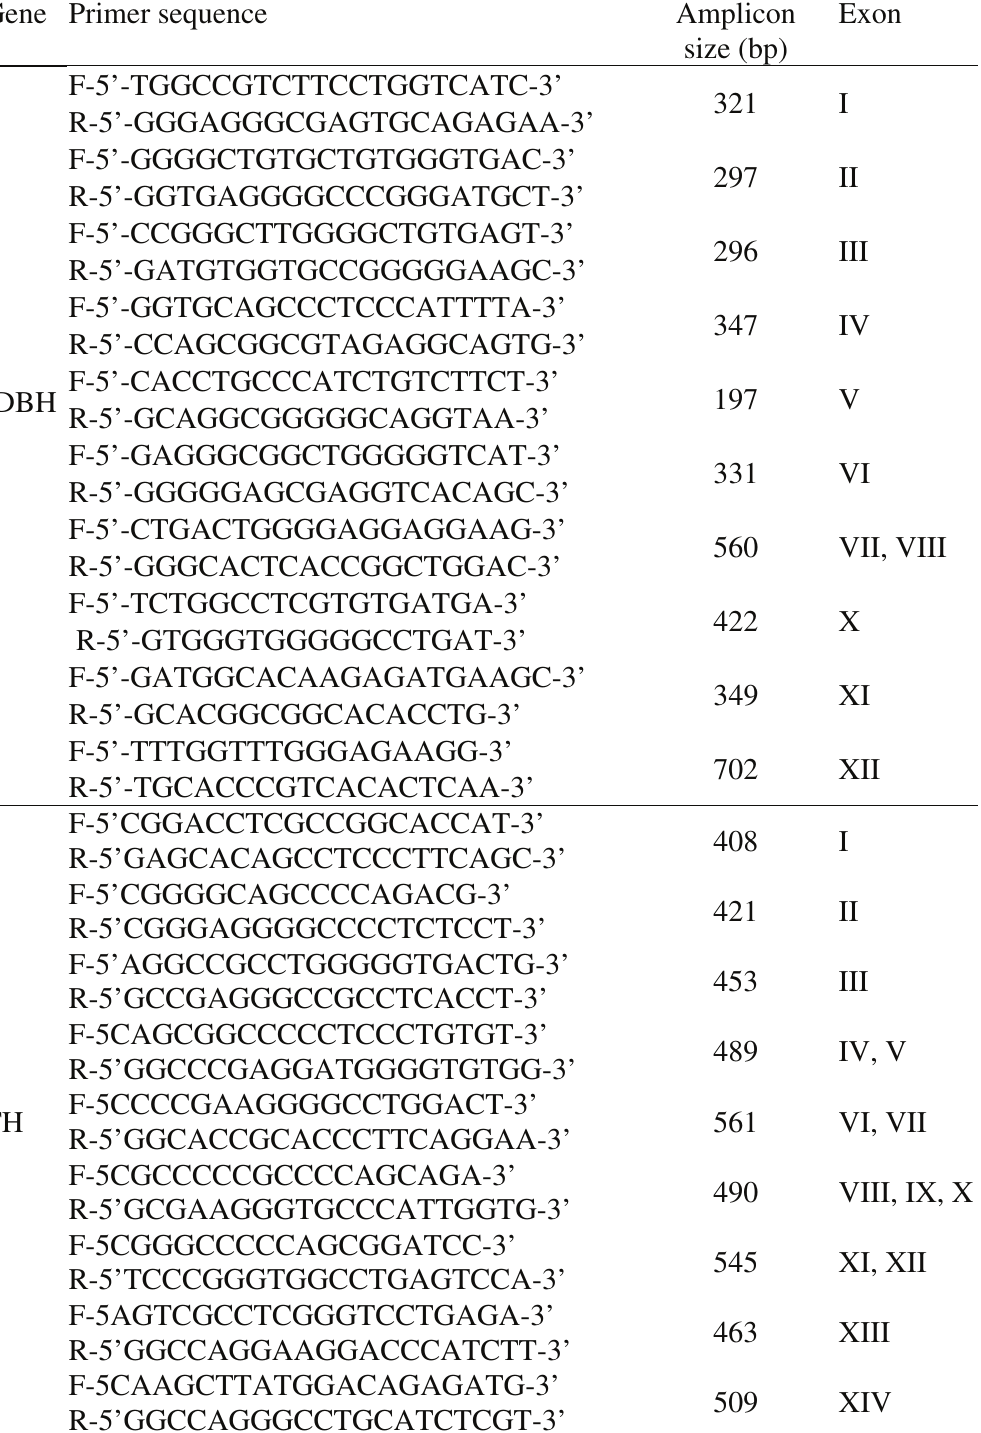
Table S1 - Primer sequences used to analyse bovine TH and DBH genes. Gene Primer